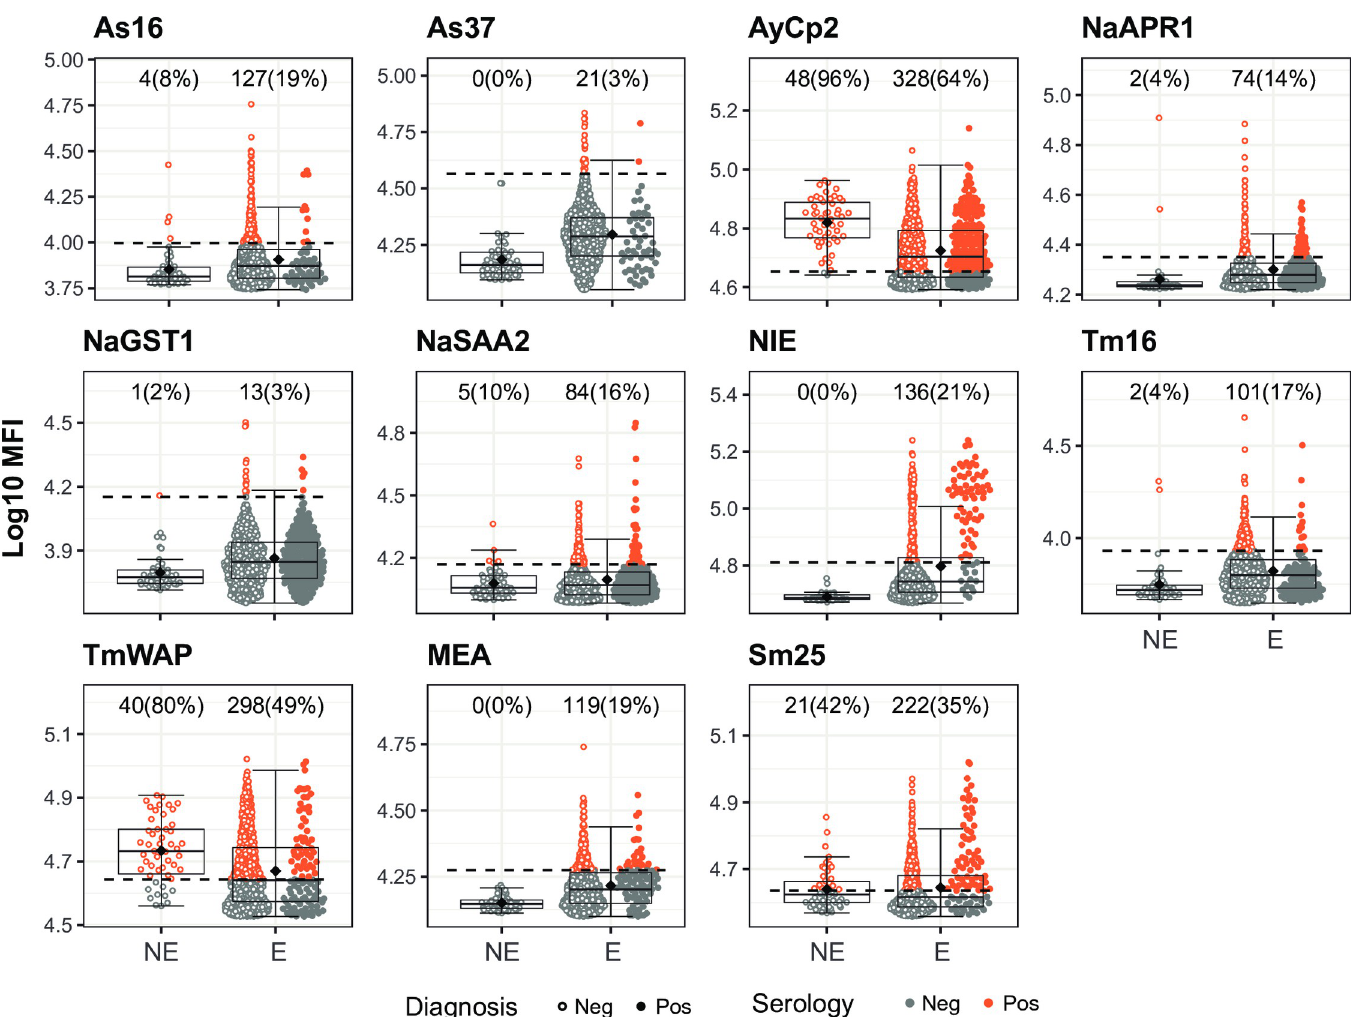
Fig 9. Helminth antigen-specific IgG levels in non-endemic and endemic populations and seropositivity cutoffs by the Expectation-Maximization algorithm. Antibody levels are presented as the log 10 -transformed median fluorescence intensity (MFI) of IgG against helminth antigens. In the endemic population, filled dots highlight individuals with a helminth infection with the corresponding parasite for each antigen detected by microscopy and/or qPCR. The dashed line represents the serology cutoff calculated with the Expectation-Maximization algorithm. Individuals above (orange) or below (grey) this cutoff were considered seropositive or seronegative, respectively. At the top of each plot, the absolute number and percentage of seropositive individuals with respect to the Non-Endemic (NE) (N = 50) or Endemic (E) (N = 715) populations are indicated. The boxplots represent the median (bold line), the mean (black diamond), the first and third quartiles (box) and the largest and smallest values within 1.5 times the interquartile range (whiskers). Data beyond the end of the whiskers are